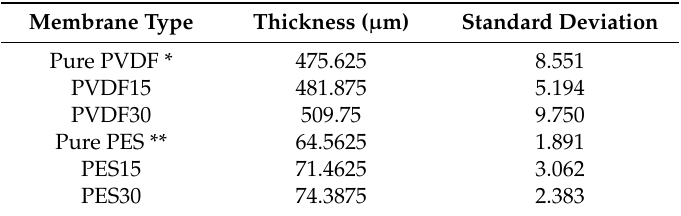
Table 1. Mean values of modified and unmodified membranes